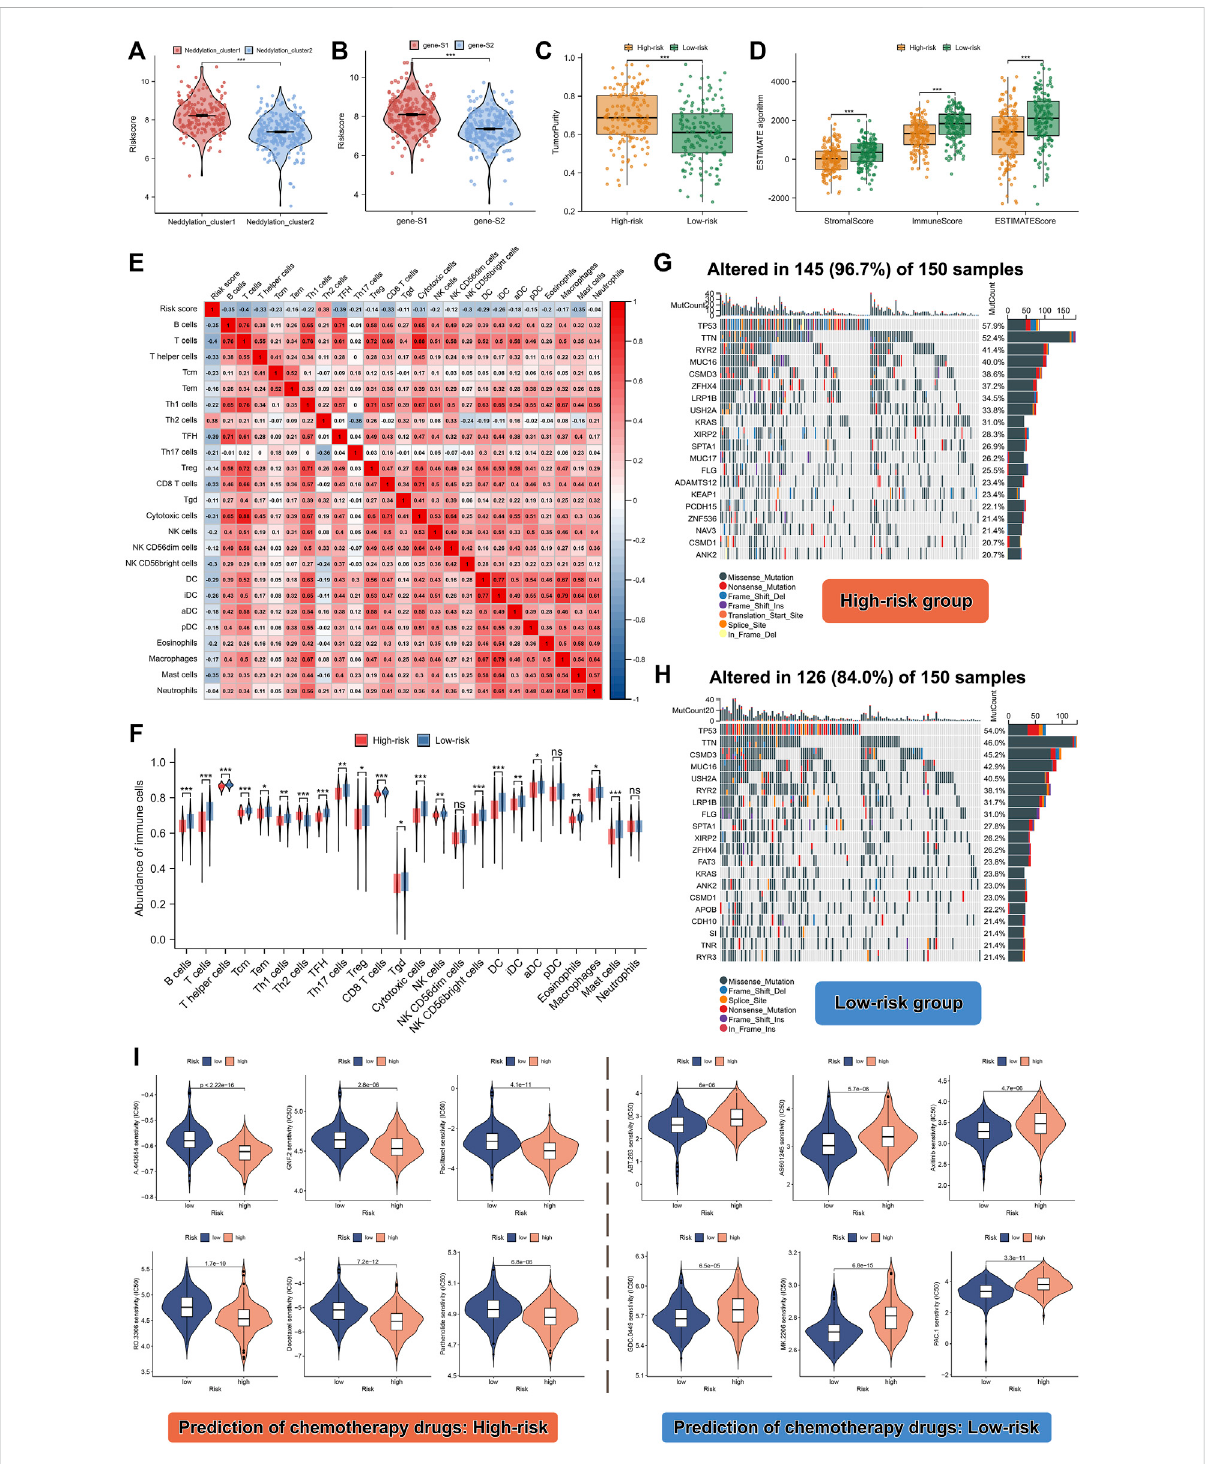
FIGURE 7 Differences in TME, mutation levels, and chemotherapeutic drug sensitivity among high- and low-risk patients. (A) Risk score between the two different neddylation patterns. (B) Risk score between the two different gene subtypes. (C,D) Tumor purity, estimate score, immune score, and stromal score between high- and low-risk groups. (E,F) Correlation between risk score and abundance of 24 immune cell types. (G,H) Correlation between risk score and genetic mutation. (I) Prediction of chemotherapeutic drugs in high- and low-risk